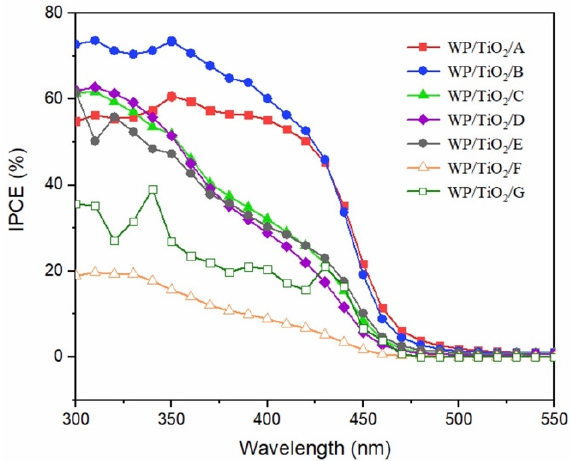
Figure 5. IPCE curves measured at − 0.68 V RHE on samples A–G with WP/TiO 2 coatings on p-GaP surface in 1M KOH electrolyte.